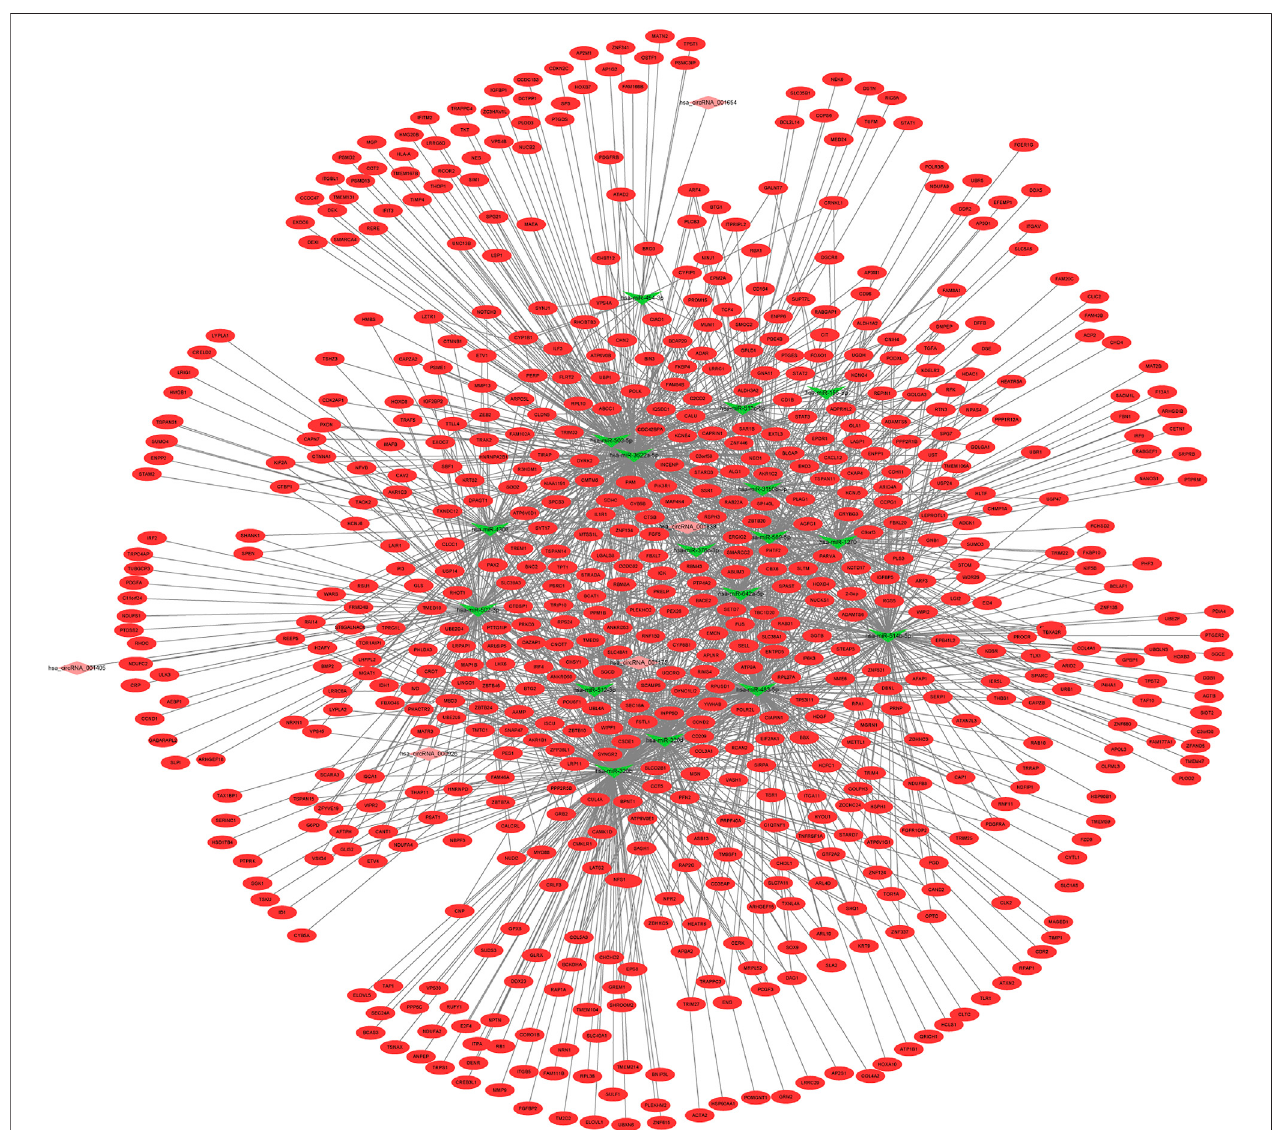
FIGURE 5 | circRNA – lncRNA – mRNA ceRNA network among DECs, DEMLs, and DEMs in IDD. DEC: differentially expressed circular RNAs; DELs: differentially expressed long non-coding RNAs; DEMs: differentially expressed mRNAs; IDD: intervertebral disc degeneration; and ceRNA: competitive endogenous RNA.